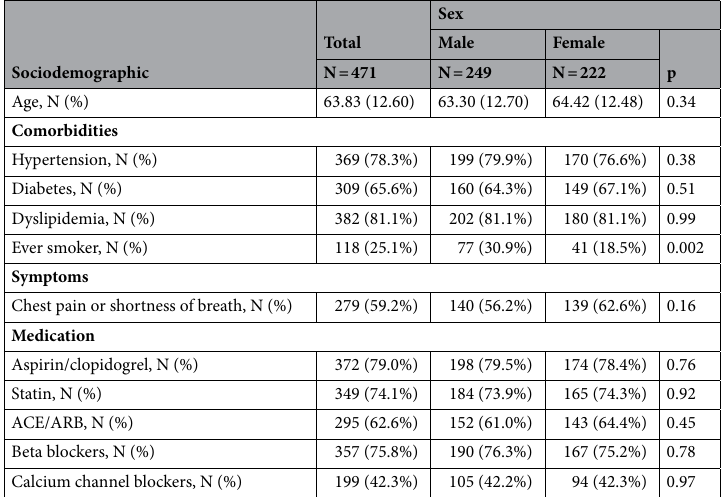
Table 1. Baseline characteristics of the study population by sex. p-value comparing women and men was calculated using Student’s t test for continuous normally-distributed variables and median testing for continuous non-normally distributed variables or chi-square test for categorical variables. ACE Angiotensin converting enzyme, ARB angiotensin receptor